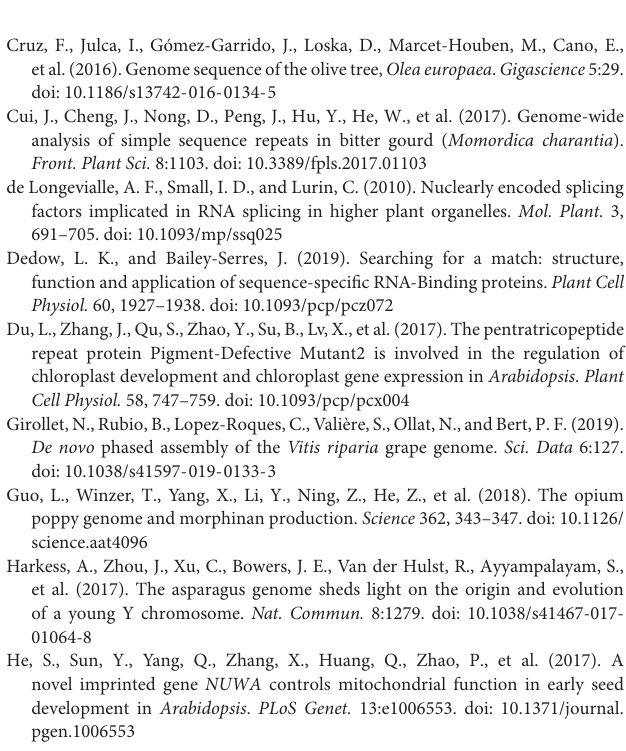
Supplementary Figure 1 | Proteins that facilitate plastid intron splicing. Introns are designated as subgroup I, IIA, and IIB, according to Michel et al. (1989). The oval represents the PPR proteins; quadrilateral refers to those proteins belonging to other families. Solid lines indicate the recent research progress mentioned in our present review paper; dashed lines indicate previous results. The arrows point to their targets. Supplementary Figure 2 | Simple working models of PPR proteins. PPR proteins can interact with RNA to affect gene expression by several ways (modified and refined from Barkan and Small, 2014). (A) PPR protein could expose (or mask) cis -elements for RNA translation, RNA splicing, RNA cleavage, or RNA editing. (B) PPR protein can activate translation via preventing the formation of an RNA structure, which masks the ribosome-binding site. (C) PPR protein can stabilize RNAs by blocking 5 (cid:48) → 3 (cid:48) and 3 (cid:48) → 5 (cid:48) exoribonucleases. Different PPR proteins are shown in different colors. Supplementary Table 1 | Phenotypes and functions of PPR proteins in plant growth and development according to this review were summarized in recent years (since 2015). Location: C, chloroplast; M,